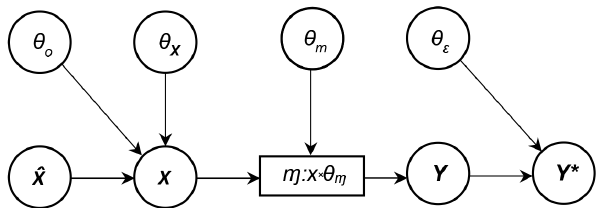
Figure 1. A configuration of a network coupling some elements in M , X , (cid:50) , Y , and Y ∗